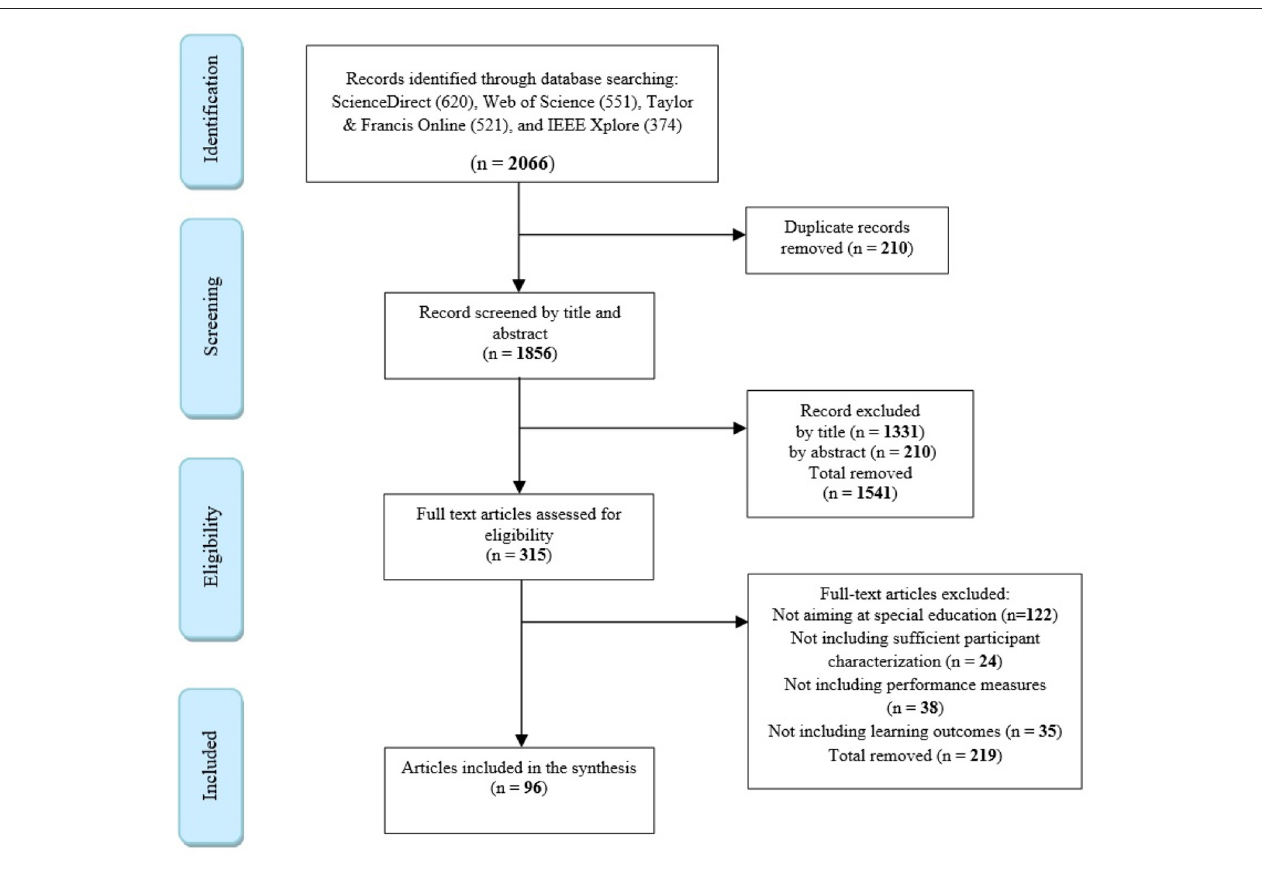
FIGURE 1 | Flow chart for the article search and selection